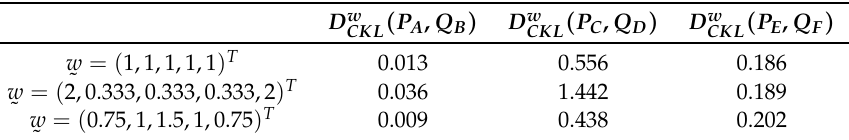
Table 3. CWKL divergence between assets A-F for various weights.